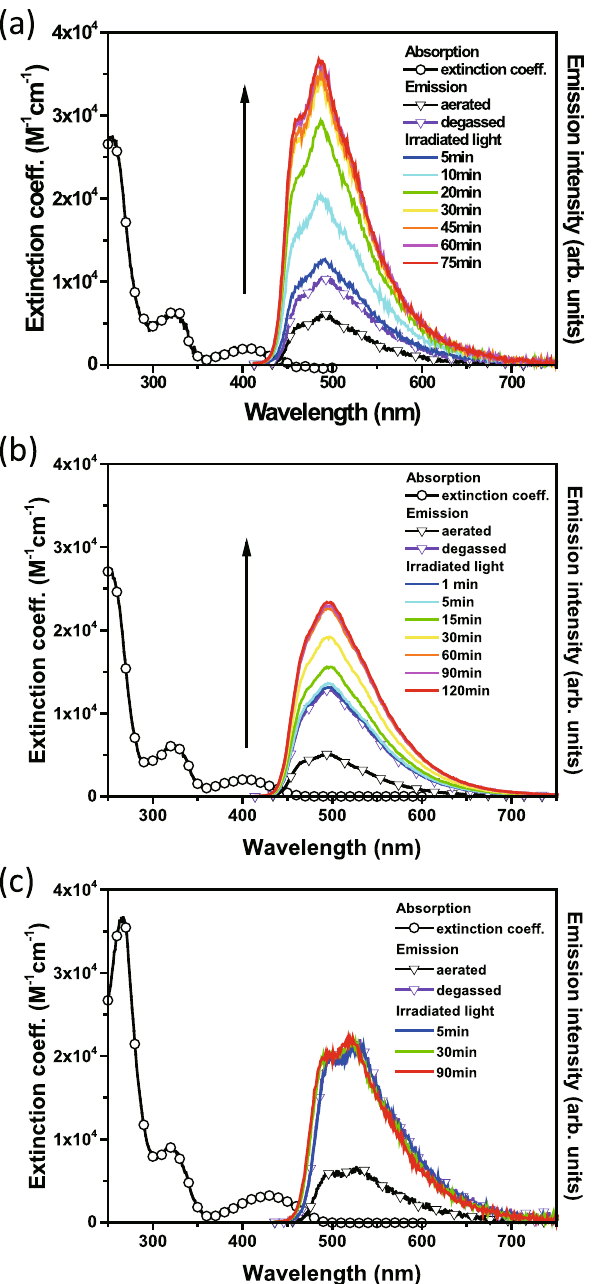
Fig. 2 Irradiation time-dependent fl uorescence spectra. Absorption and emission spectra of PZDN ( a ), PZTN ( b ), and PZQN ( c ) are measured in cyclohexane ( λ ex = 405 nm). Note that the arrow represents the increment of emission intensity with photolysis time.